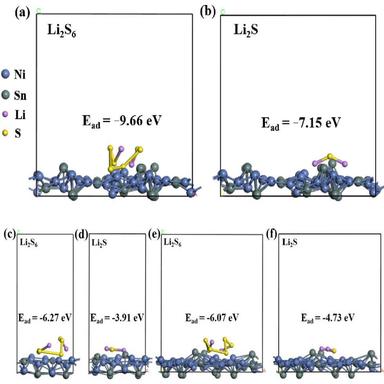
Binding configurations and adsorption energies of (a) Li2S6 and (b) Li2S on the Ni3Sn2 (2 0 1) plane, (c) Li2S6 and (d) Li2S on the Ni3Sn2 (0 2 0) plane, and (e) Li2S6 and (f) Li2S on the Ni3Sn2 (11 2) plane.